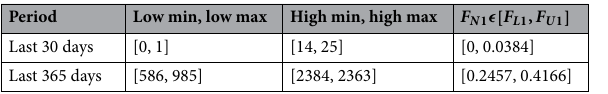
Table 2. U.S monthly records.